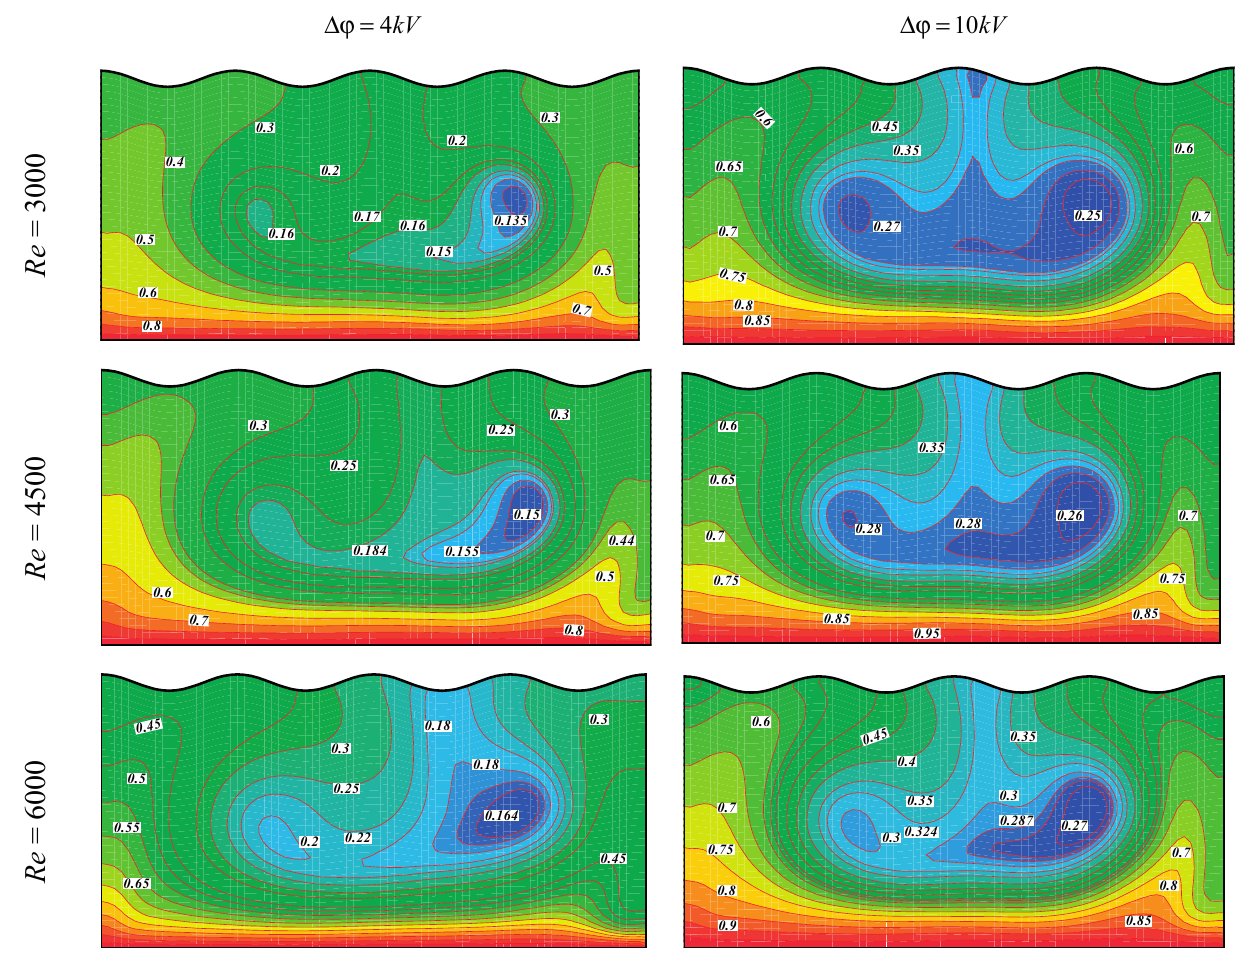
Figure 2. Electric density distribution injected by the bottom